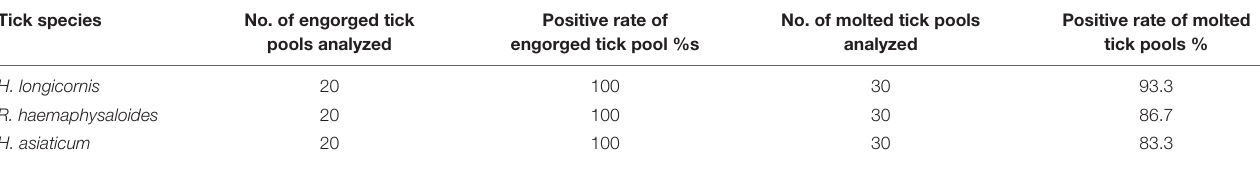
TABLE 2 | Infection of larvae ticks by exposure to mice infected with B. microti. Tick